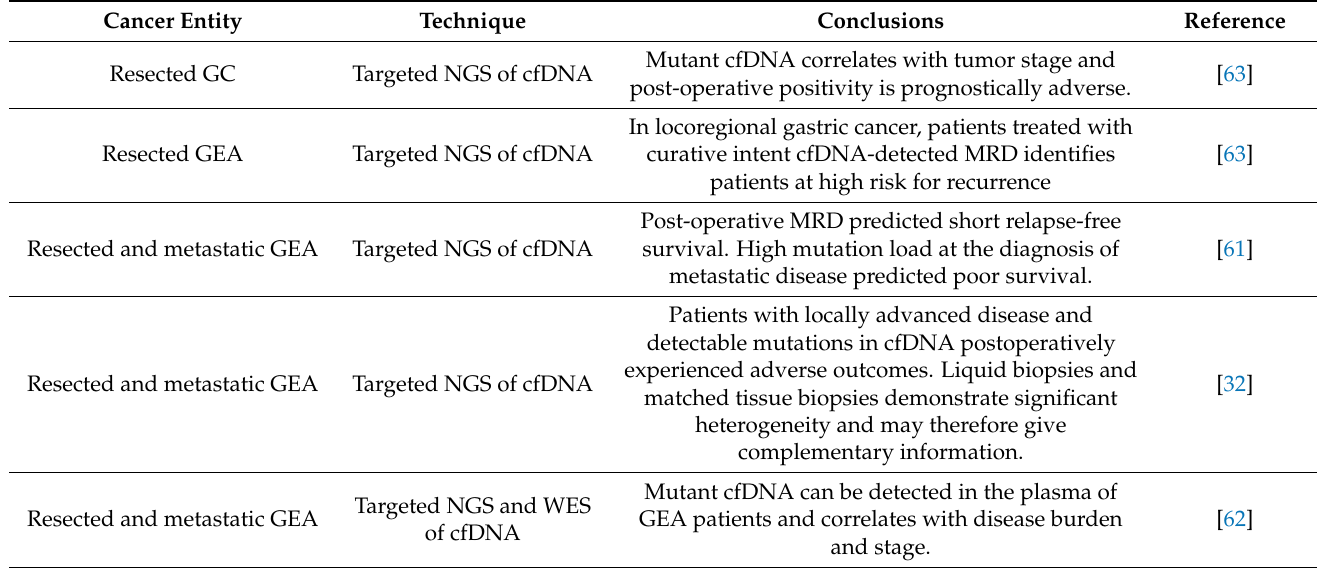
Table 2. Key studies on liquid biopsy applications in gastric and gastroesophageal cancer